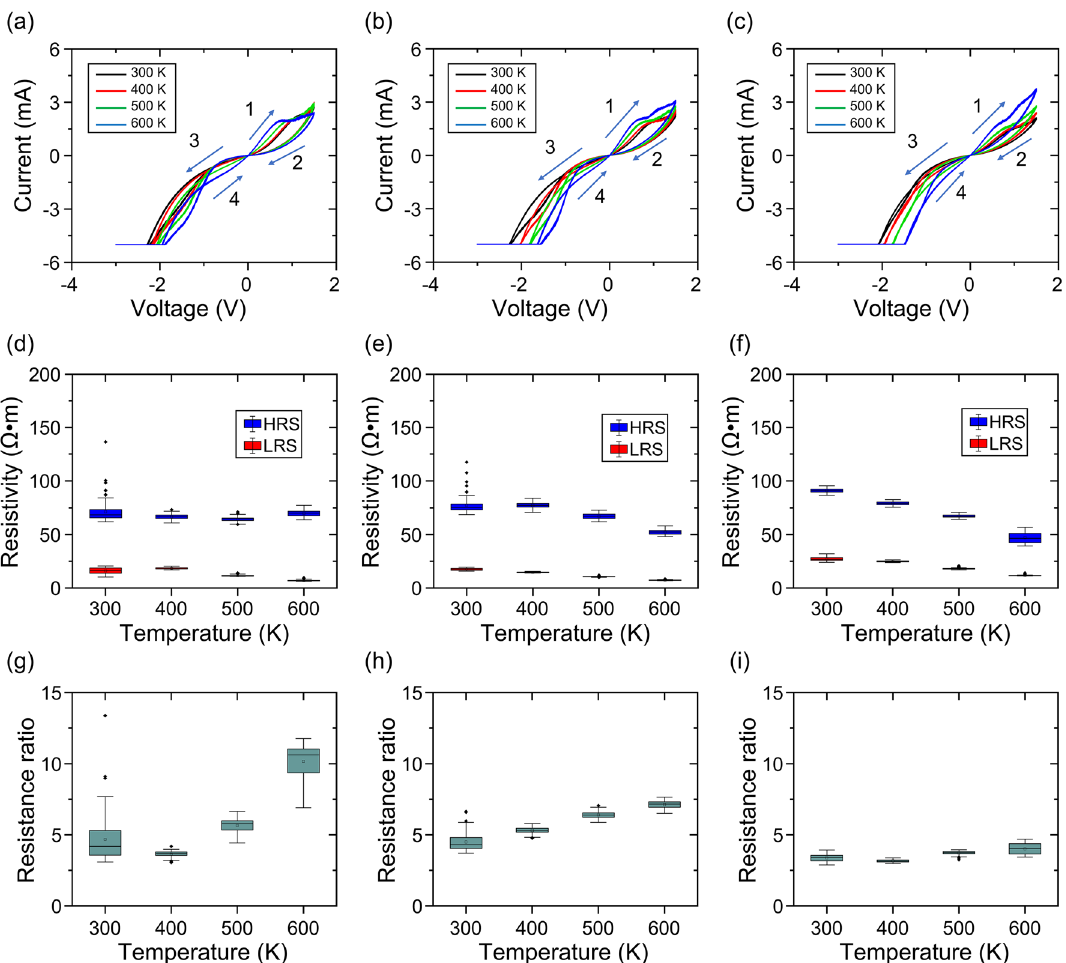
Figure 3. Temperature-dependent properties from 300 to 600 K. I–V curves of samples ( a ) G05, ( b ) G10, and ( c ) G15; HRS and LRS resistivity of samples ( d ) G05, ( e ) G10, and ( f ) G15; resistance ratio of samples ( g ) G05, ( h ) G10, and ( i )